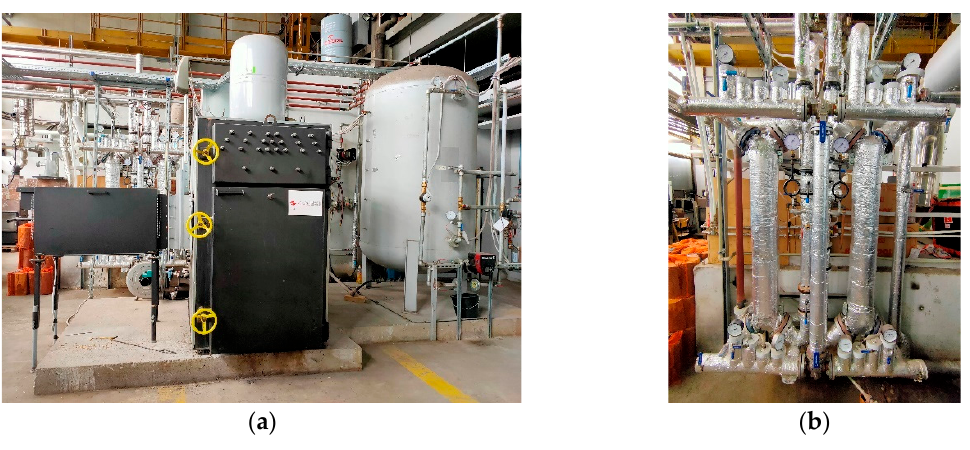
Figure 4. The view of ( a ) the boiler with a fuel feeder; ( b ) evaporator and Figure 3. The view of ( a ) the boiler with a fuel feeder; ( b ) evaporator and superheater.